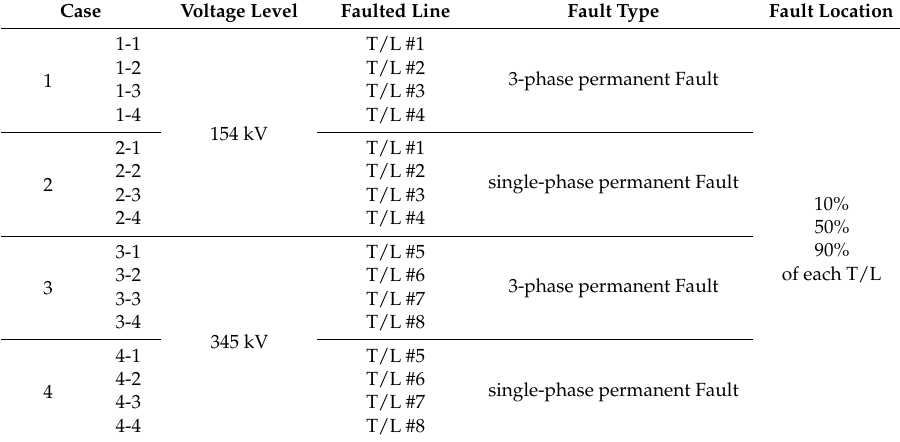
Table 1. Simulation cases.